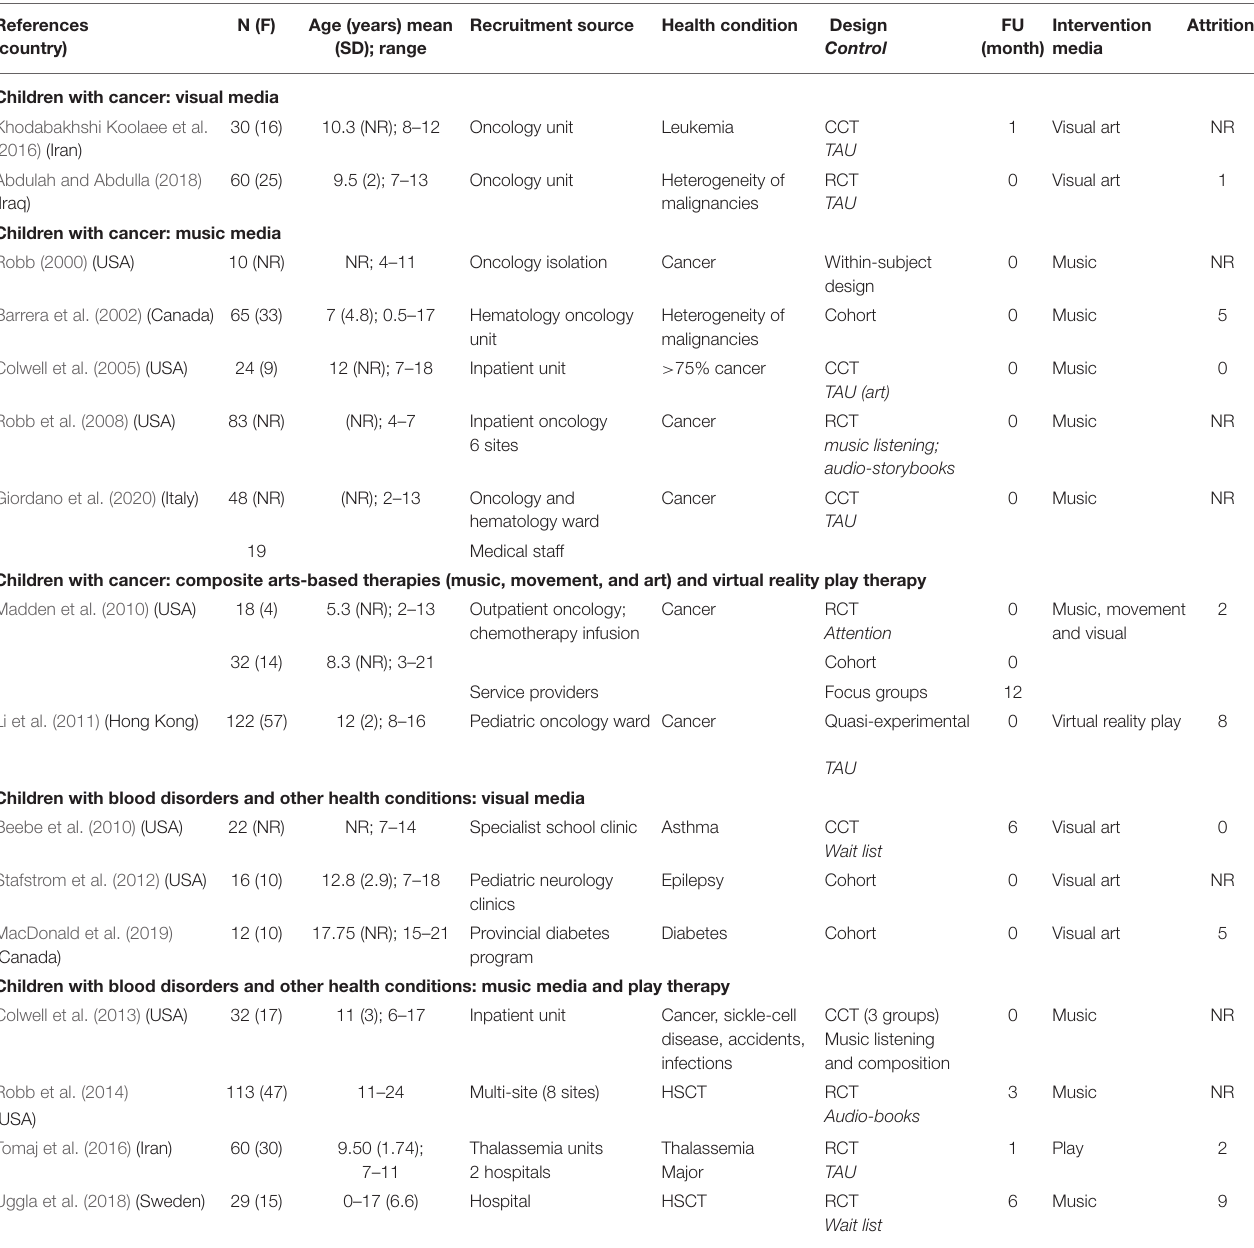
TABLE 2 | Participant, study, and intervention characteristics.